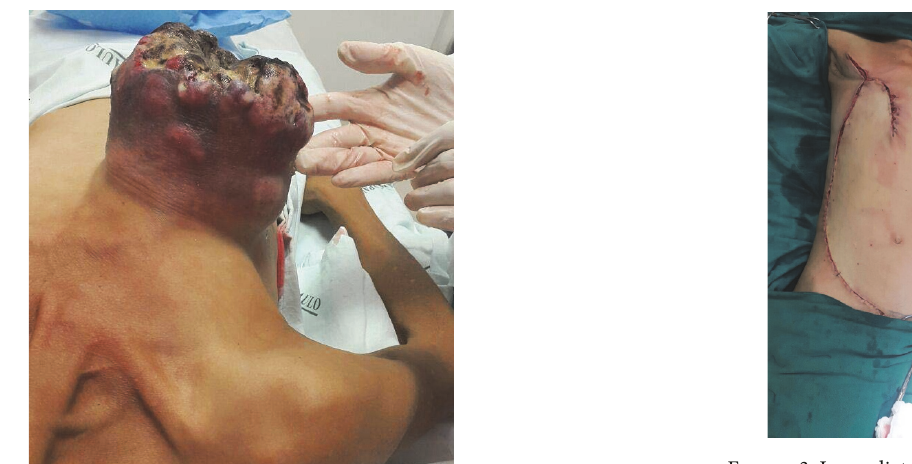
Figure 3: Immediate